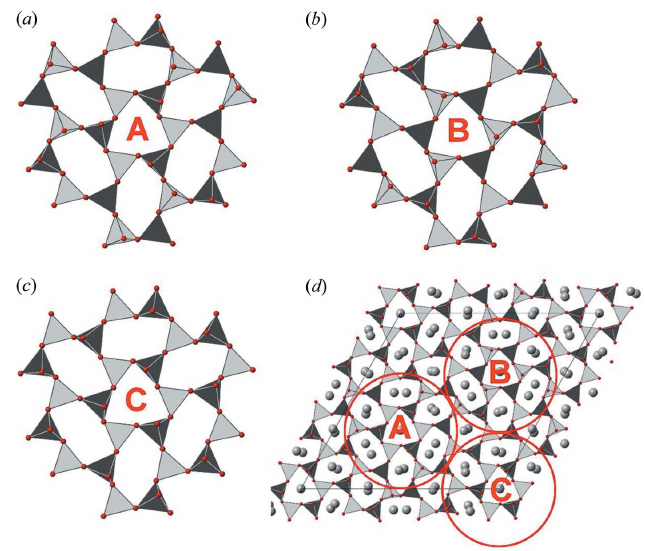
Figure 7 The crystal structure of kaliophilite as seen down c , with the three corollas indicated. ( a ), ( b ), ( c ) The three symmetry-independent corollas, A, B and C, occurring in kaliophilite are formed by a trigonal ring (1-3-5) at the center and six oval rings around it. The topologies of the oval rings are (1-2-4) and (1-2-3) in corollas A and B, whereas they are (1-3-5) in corolla C. Corollas A and B are related by the translation vector t = (1/3) a (cid:2) (1/3) b + (1/2) c . ( d ) A drawing of the crystal structure of kaliophilite as seen down c , where the locations of the corollas, A, B and C, are emphasized by red